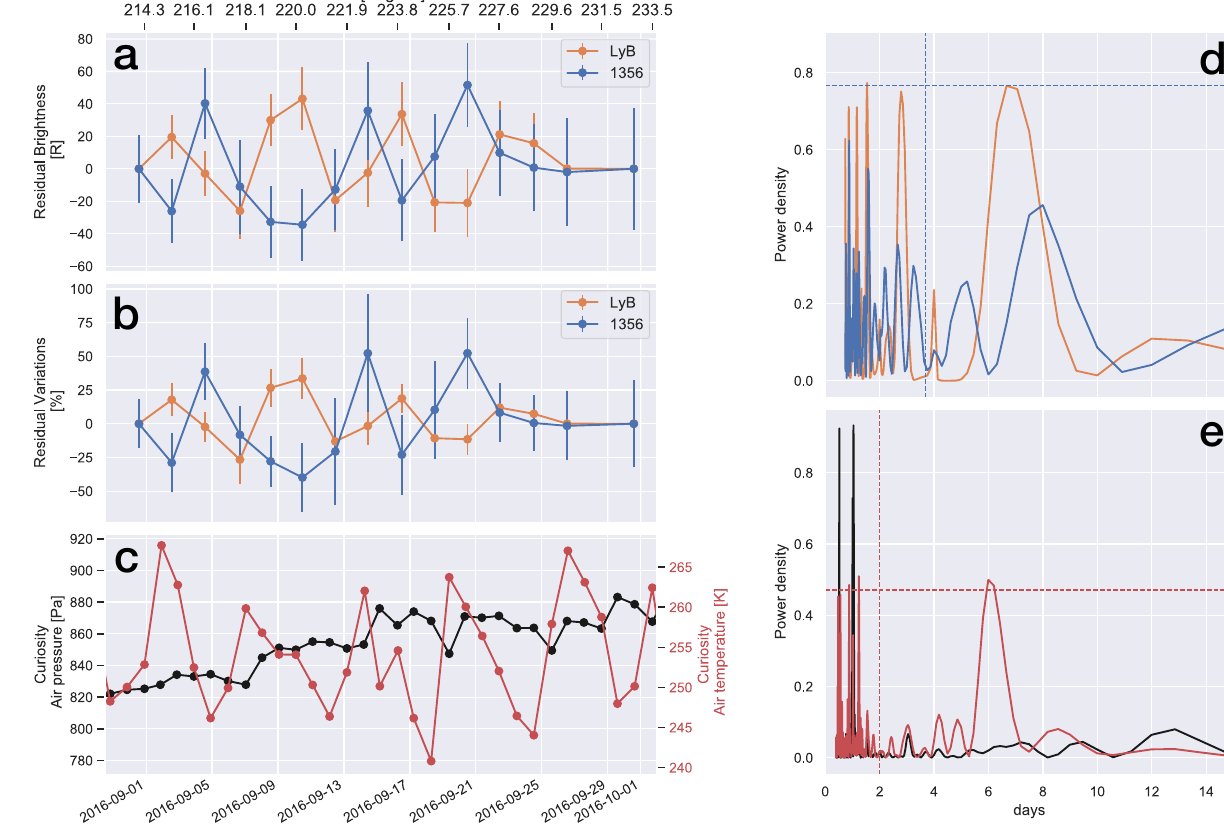
Fig. 3 | Variations in hydrogen and oxygen airglow, air temperature, and air pressure during dust storm. Time series of a Ly- β and b OI 1356 airglow residual brightness according to rolling average data (the error bars denote 1 σ standard deviation);and c averageairpressureandtemperatureatlocaltimesof6hand18h, as observed by Rover Environmental Monitoring Station (REMS). Normalized